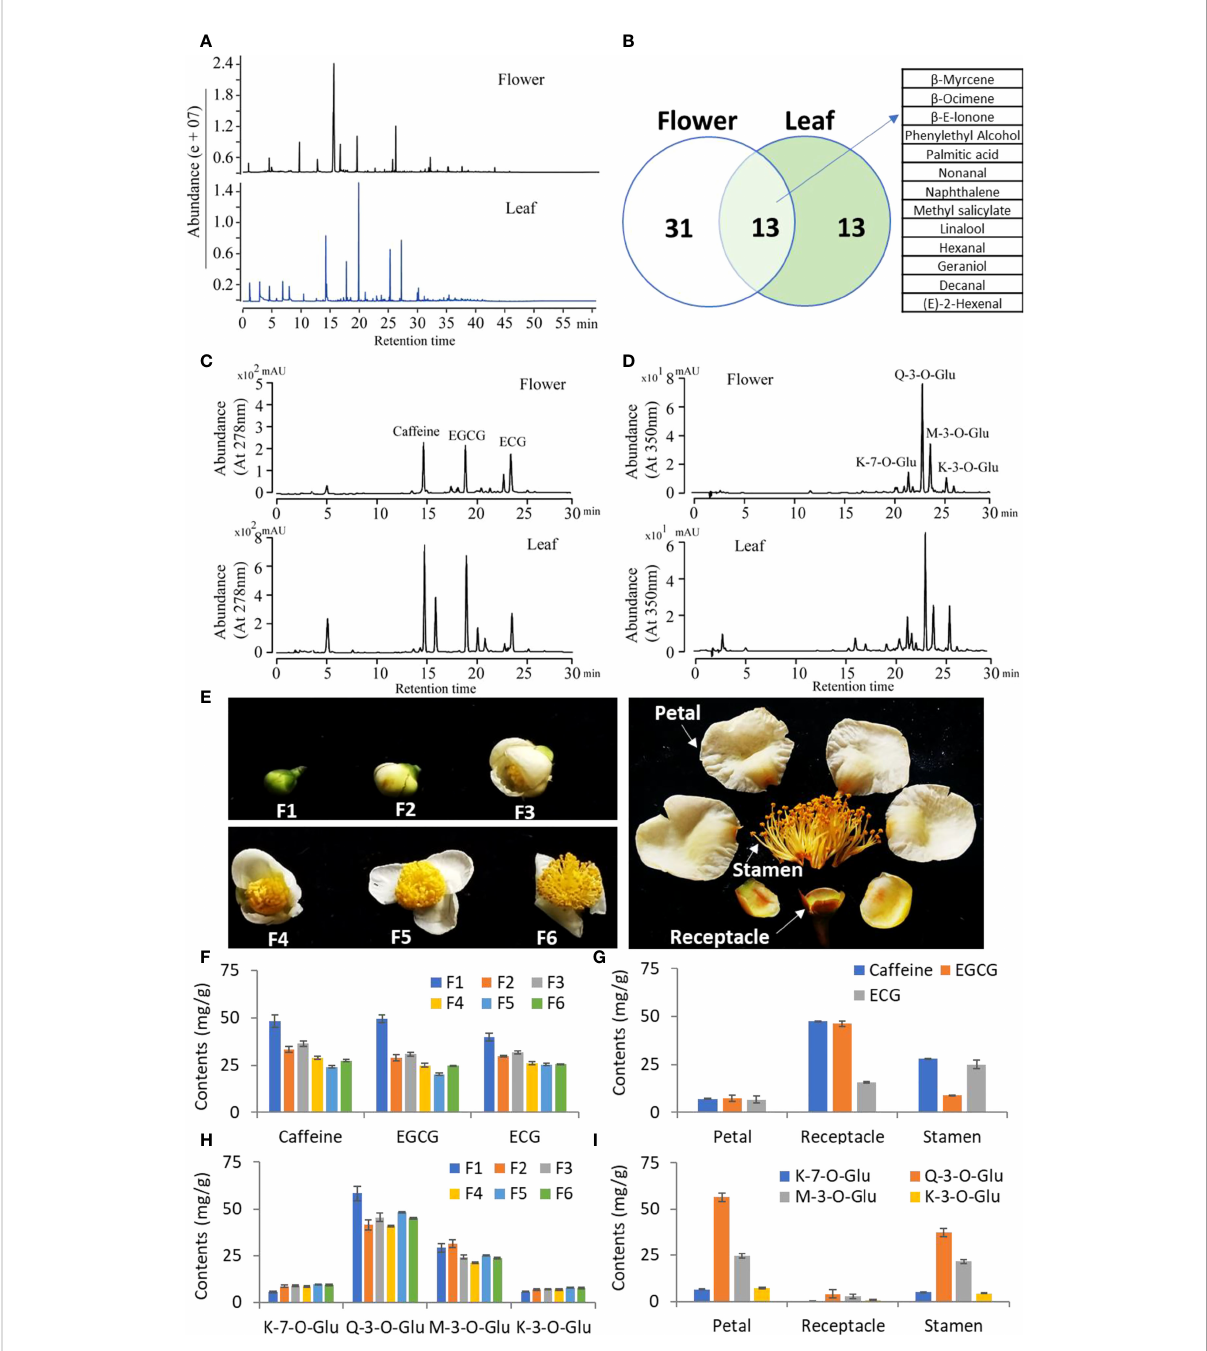
FIGURE 2 Metabolic analysis of tea fl owers and leaves. (A) GC-MS total ion current of volatiles in tea fl owers and leaves. (B) Venn diagram showing the variation of volatile compounds in tea fl owers and leaves. (C, D) HPLC chromatographs of catechins and caffeine (C) and fl avonols (D) in tea fl owers and leaves. The compound names are listed on top of the peaks. EGCG, epigallocatechin gallate; ECG, epicatechin gallate; K-7-0-Glu, kaempferol-7-O-glucoside; K-3-0-Glu, kaempferol-3-O-glucoside; Q-3-0-Glu, quercetin-3-O-glucoside; M-3-0-Glu, myricetin 3-O- glucoside. (E) Phenotype of developing tea fl owers. F1, fl ower stage 1; F2, fl ower stage 2; F3, fl ower stage 3; F4, fl ower stage 4; F5, fl ower stage 5; F6, fl ower stage 6. (F, G) Contents of caffeine and catechins in developing tea fl owers (F) and different parts of tea fl owers (G) . (H, I) Contents of fl avonols in developing tea fl owers (H) and different parts of tea fl owers (I) . All data are from at least three biological replicates and are expressed as mean ±